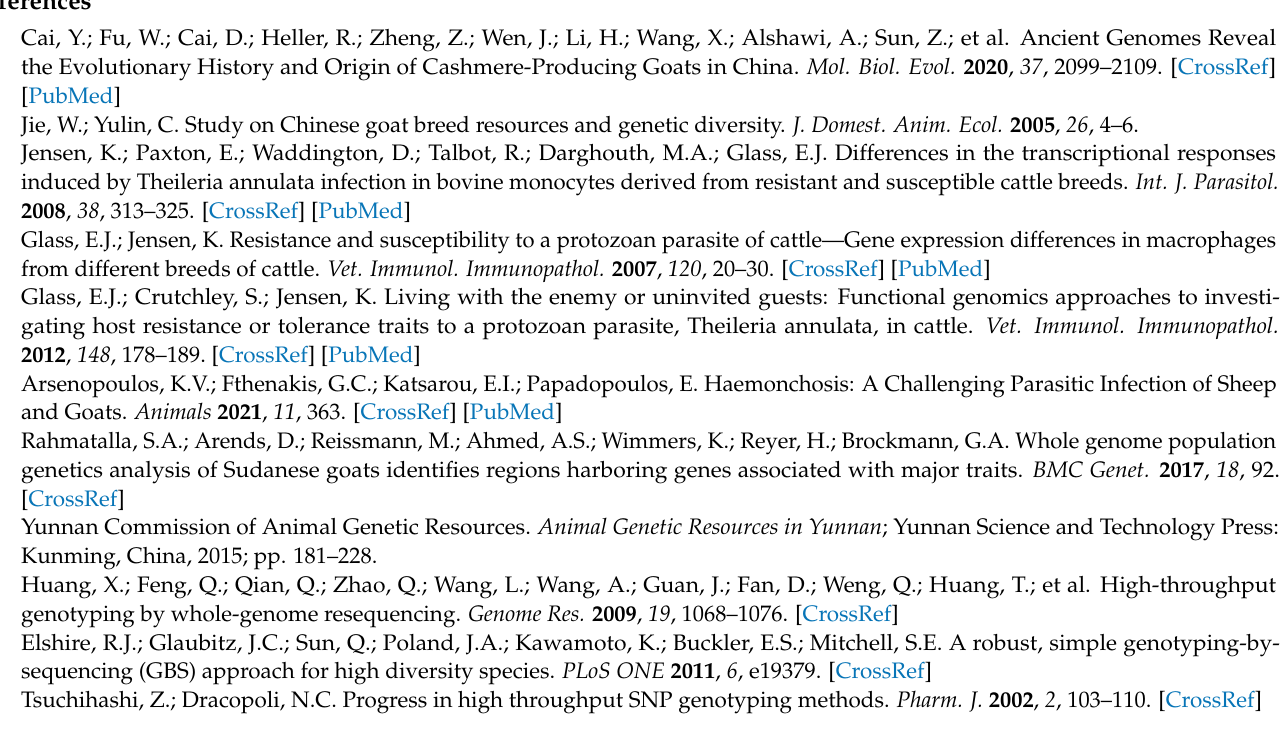
Table S2: Statistical table of the results of genome Alignment; Table S3: Statistical table of SNP; Table S4: Statistical table of